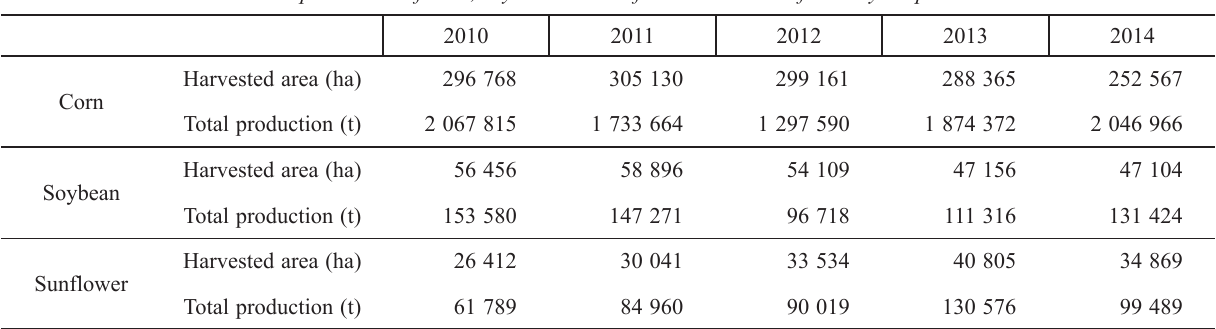
Table 1 – Harvested area and production of corn, soybean and sunflower in Croatia for a 5-year period